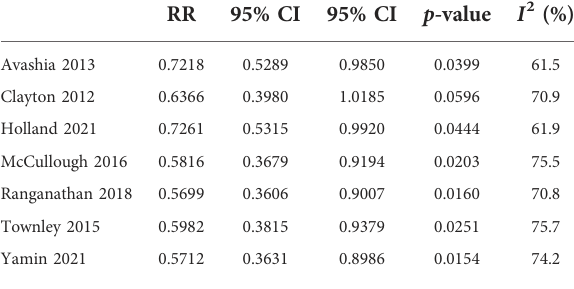
TABLE 2 Sensitivity analysis for the association between antibiotic use and infection after breast